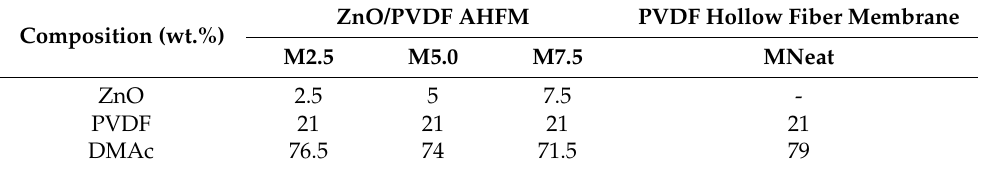
Table 1. Compositions of the polymer dope solutions. Composition